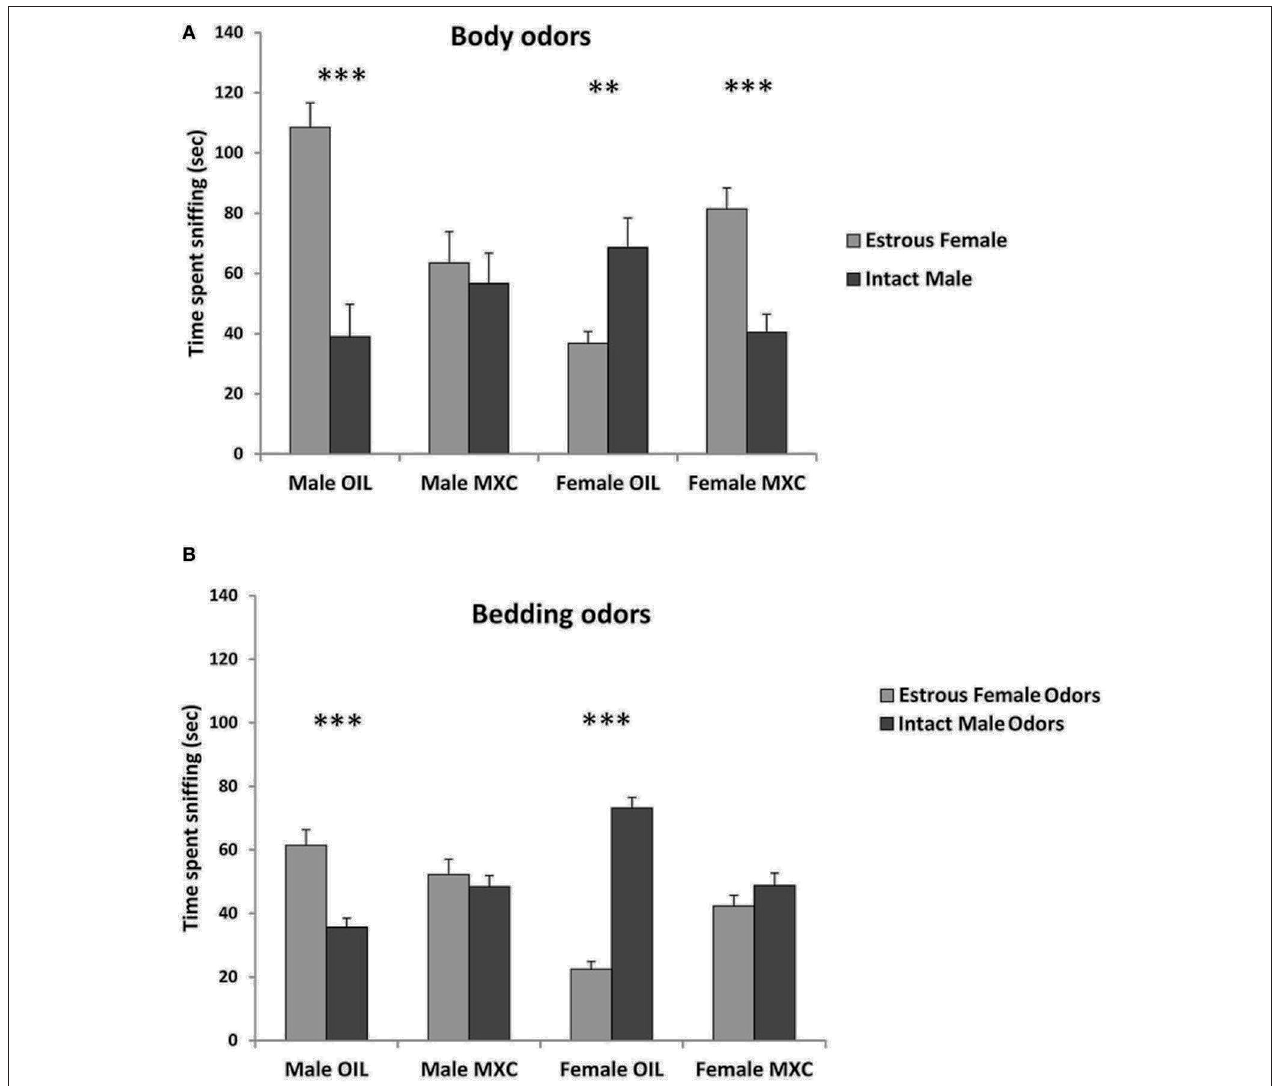
FIGURE 4 | Tests of sexual preference. (A) Test of sexual preference using anesthetized conspecifics. Male mice treated with OIL show a typical preference for estrous female while MXC treated males do not show any preference. By contrast to OIL treated males, OIL treated females show a preference for male over estrous female and MXC exposed females show the opposite pattern of response (i.e. a preference for estrous female). (B) Test of olfactory sexual preference using soiled bedding by intact male vs. estrous female. When repeating the preference test using odors derived from soiled bedding rather than anesthetized conspecifics, the same pattern of response was observed with the exception of MXC treated female mice that now failed to show any preference for estrous female odor over intact male. For all graphs: ** p < 0.01, *** p < 0.001 for OIL vs. MXC